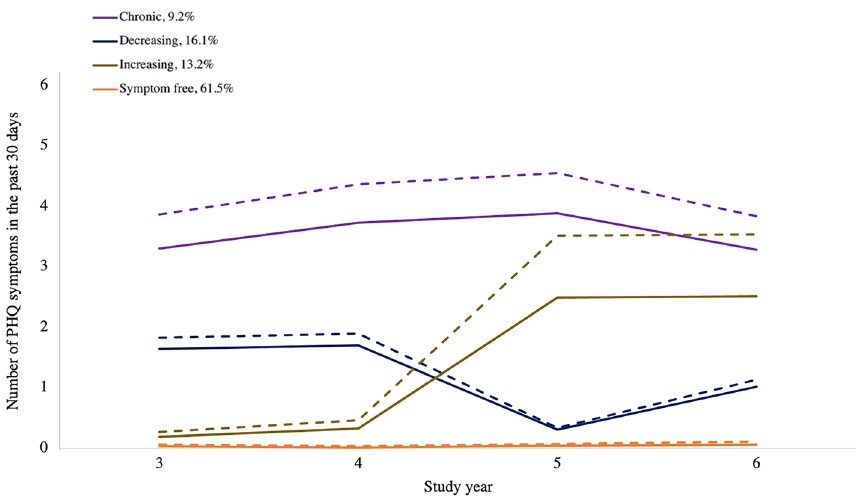
Figure 2. Latent trajectories for number of PHQ-9 depression symptoms in the past 30 days across four follow-up years, modeled using a zero-inflated Poisson distribution, with and without past-year stressors at each follow-up year while holding PTSD constant (n = 1844). Dotted line = one or more past-year stressors at every time point, but no past-year PTSD or deployment at any time point, to isolate the potential effect of stressors. Solid line = no stressors, PTSD, or deployment in the past year at any time point. PHQ = Patient Health Questionnaire (nine total symptoms). PTSD = posttraumatic stress disorder. Controlling for biological sex, age group, self-reported race and ethnicity, marital status, income, education, rank, time-varying PTSD, and time- varying deployment experience. One participant was excluded from this model due to missing